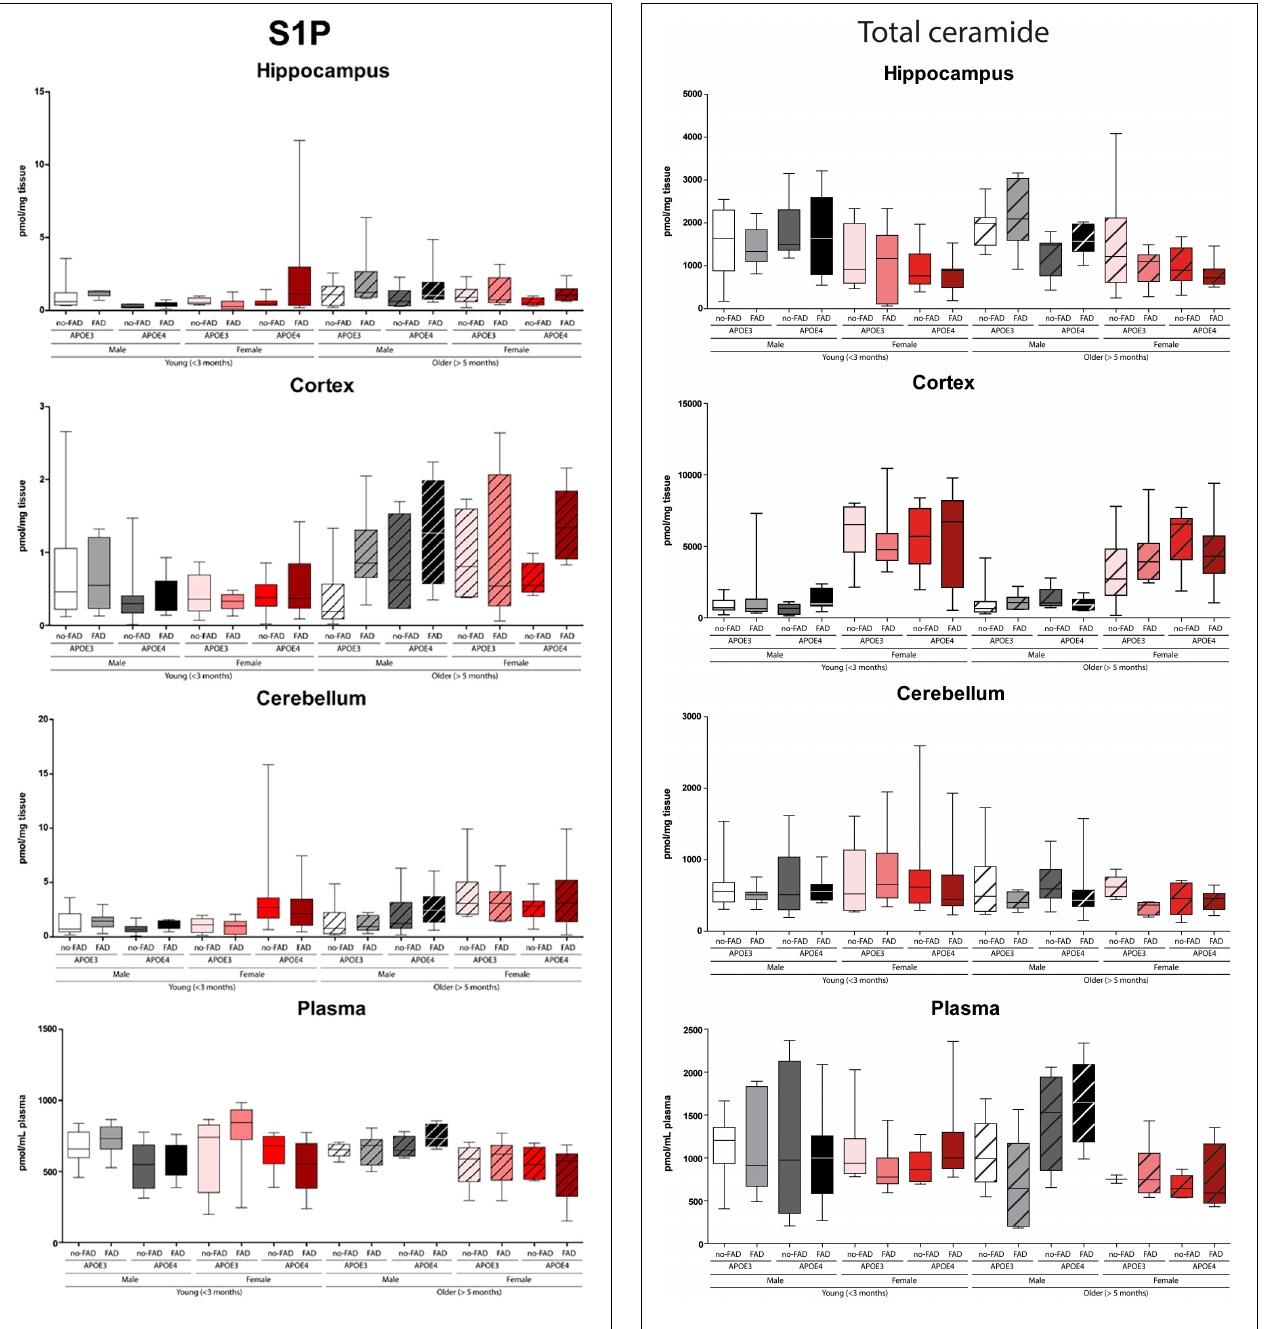
FIGURE 1 | Sphingosine-1-phosphate (S1P) levels in hippocampus, cortex, cerebellum, and plasma. Data are provided as median (line, box dimensions 25th–75th percentile, whiskers min–max) in pmol/mg tissue or pmol/mL plasma ( n = 7–10 mice per group for brain samples and n = 4–10 per group for plasma samples).